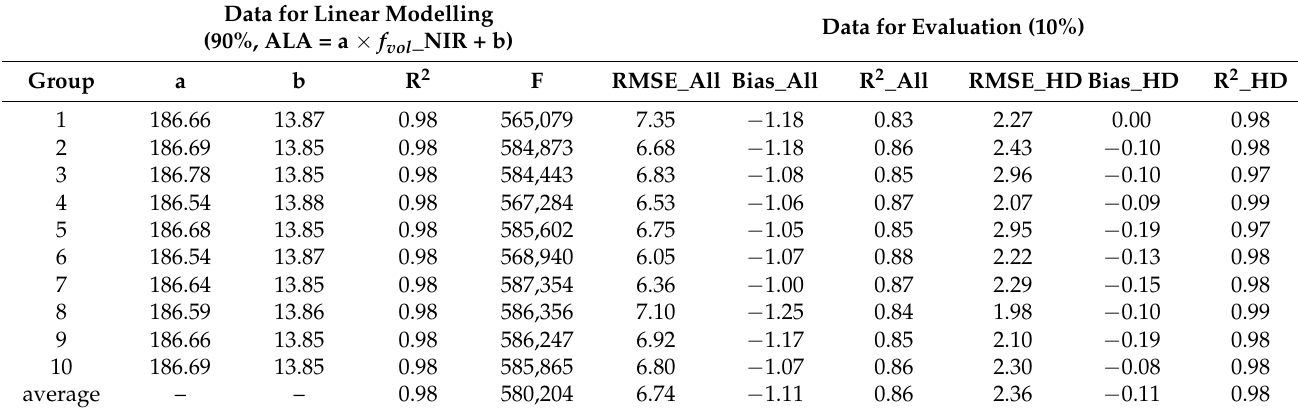
Table 3. Regression coefficients and accuracies of the linear relationships between the ALA and f vol in the NIR band. Data for Linear